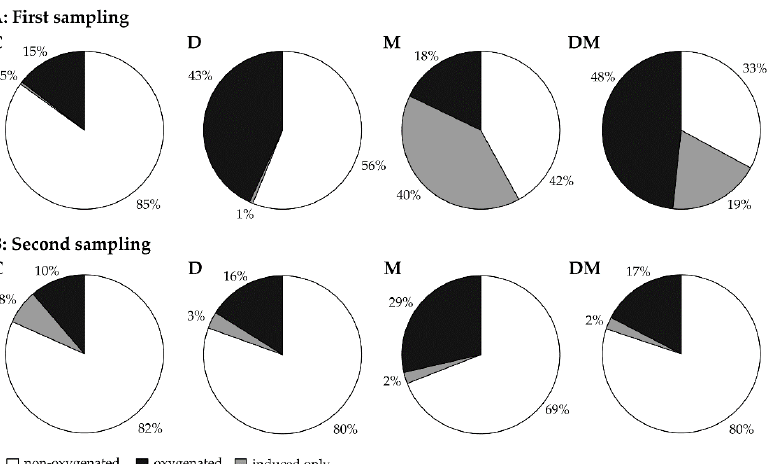
Figure 4. Effect of application of drought (D) and MeJA (M), drought + MeJA (DM), separately and combined (D + M), on the composition of monoterpenes of Picea glauca needles at first ( A ) and second ( B ) sampling points; C, control .